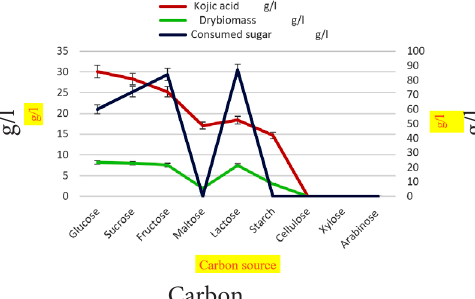
Fig.3. Effect of various carbon source on synthesis of kojic acid drymass and consumption of sugar by A.flavus